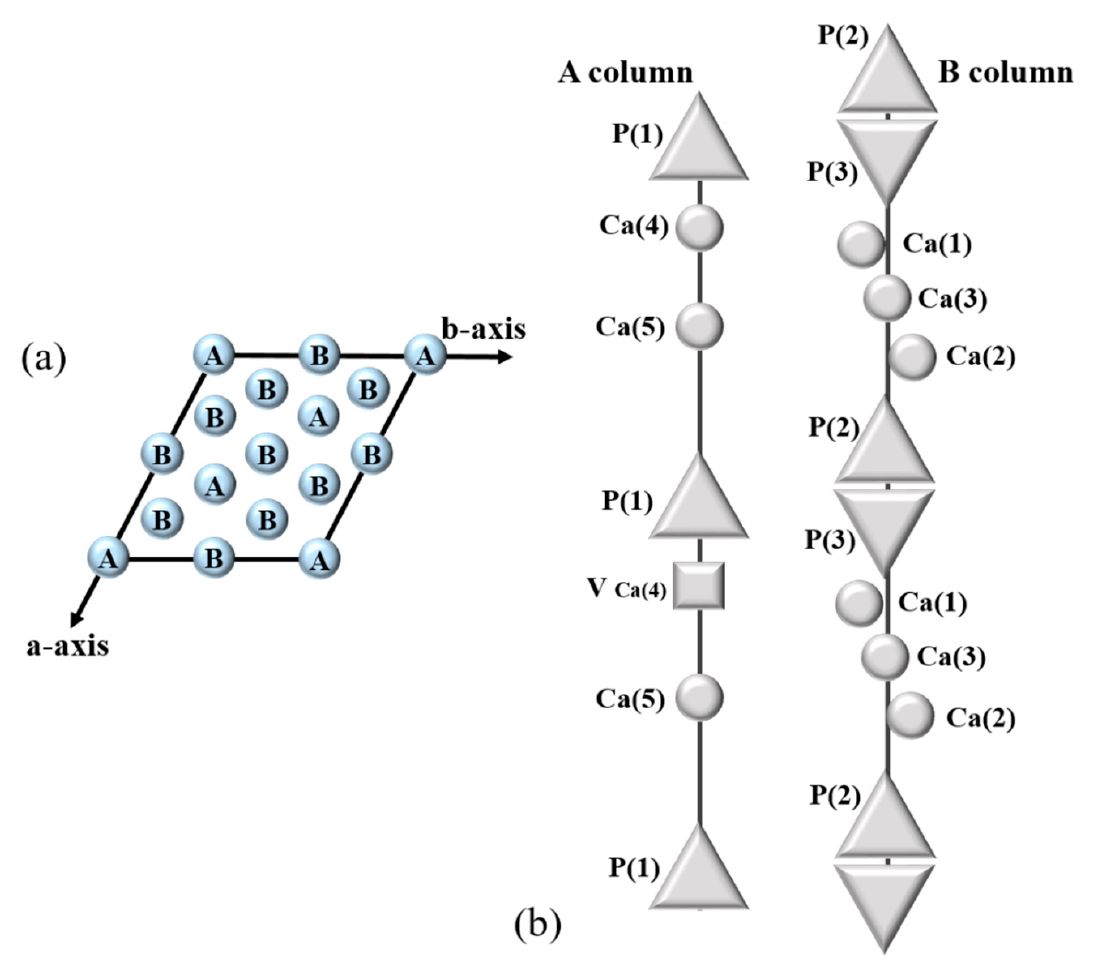
Figure 2. Crystal structure model of β -TCP from the view of ( a ) c-axis and ( b ) along the c-axis (modified from Yoshida et al., 2006 [26]).